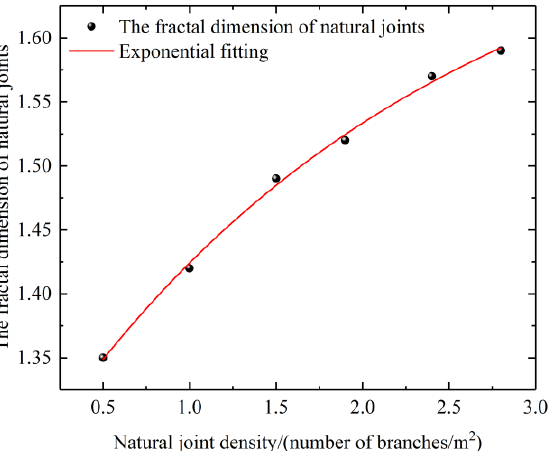
Figure 5. Relation curve between the fractal dimensions of natural joints and the natural joint den- sity.